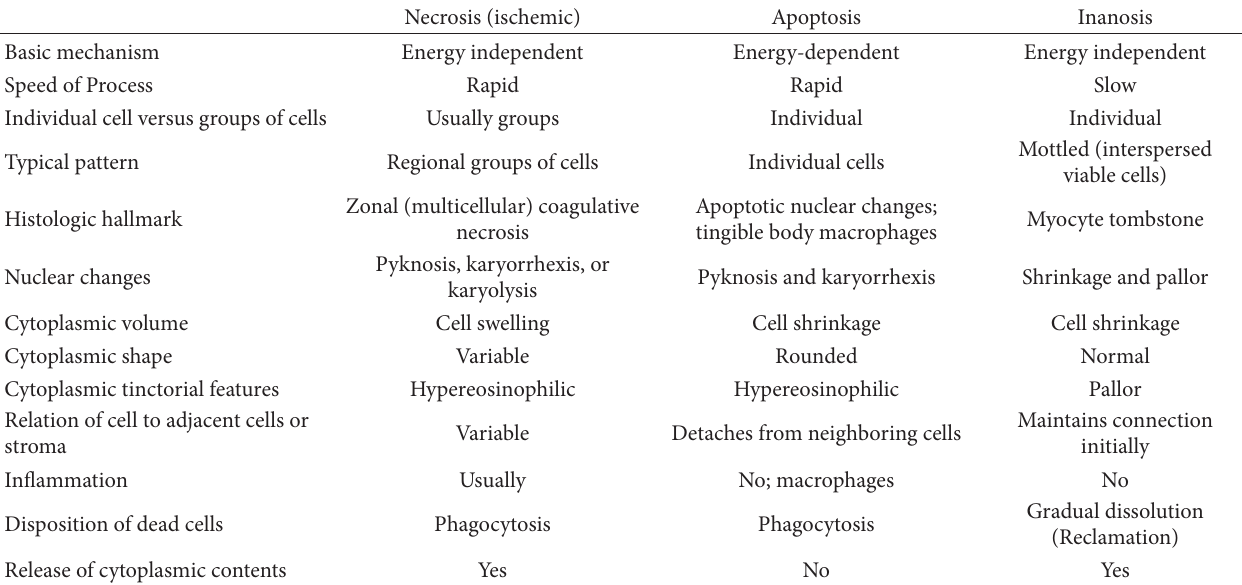
Table 4: Comparison of necrosis, apoptosis, and